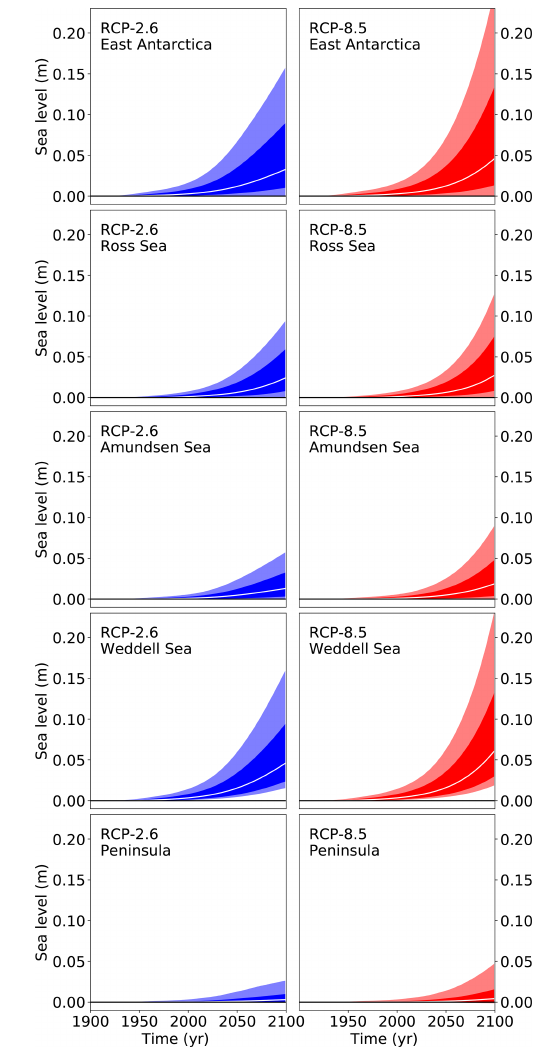
Figure 11. Projections from all models of the future sea level con- tribution of the different Antarctic sectors following the procedure depicted in Fig. 1 and detailed in Sect. 2. The white line represents the median value, the dark shading the likely range (66th percentile around the median), and the light shading the very likely range (90th percentile around the